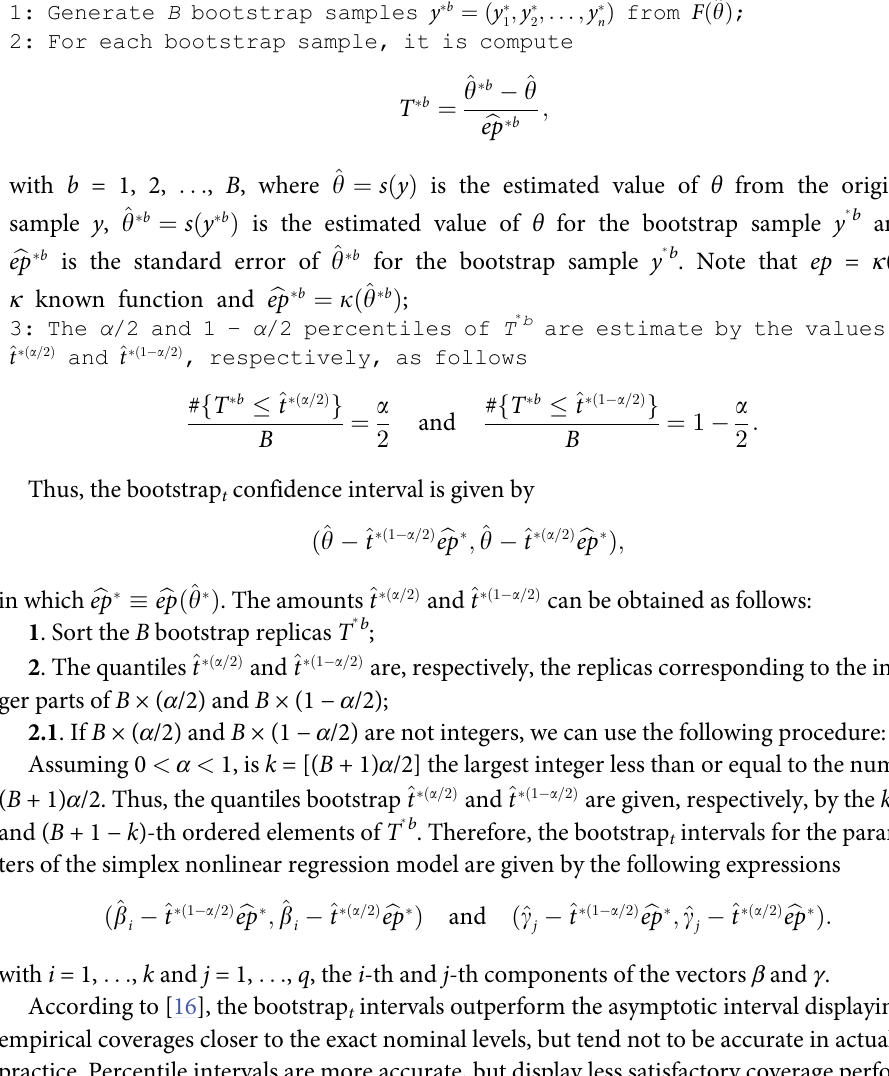
Algorithm 3 : Bootstrap confidence interval—Bootstrap